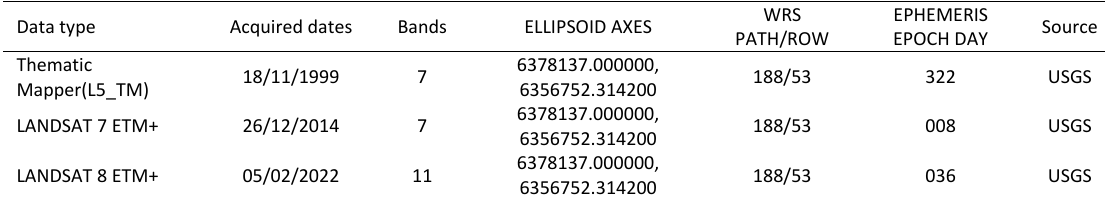
Table 1. Image data used